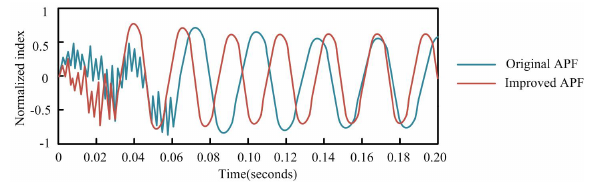
Fig. 5. Comparison of Normalization Exponents of Two Filters